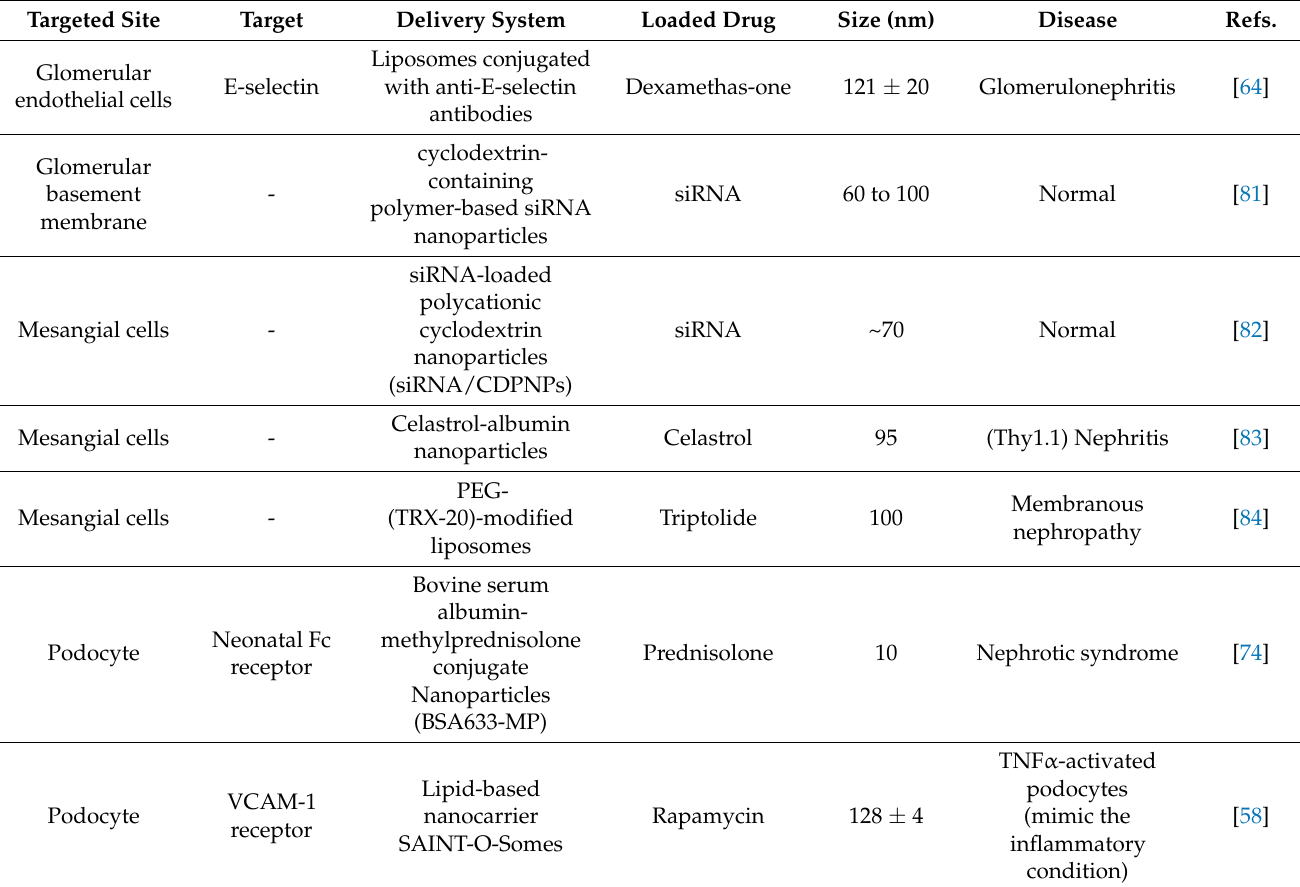
Table 1. Renal delivery system sorted according to the targeted